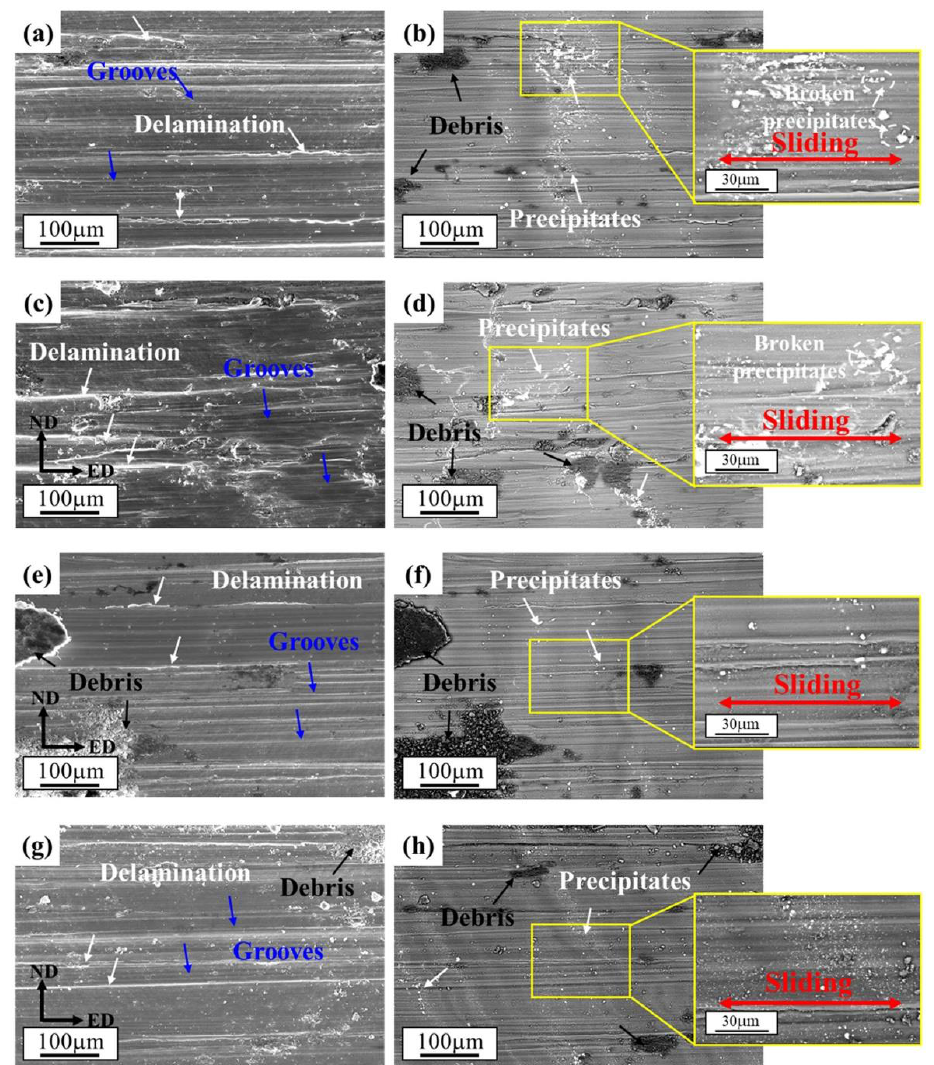
Figure 12. SEM morphologies of worn surfaces after friction testing in different signals: ( a , b ) ho- mogenized, ( c , d ) 1P, ( e , f ) 4P and ( g , h ) 12P samples. Images of ( a , c , e , g ) are in SE and ( b , d , f , h ) are in